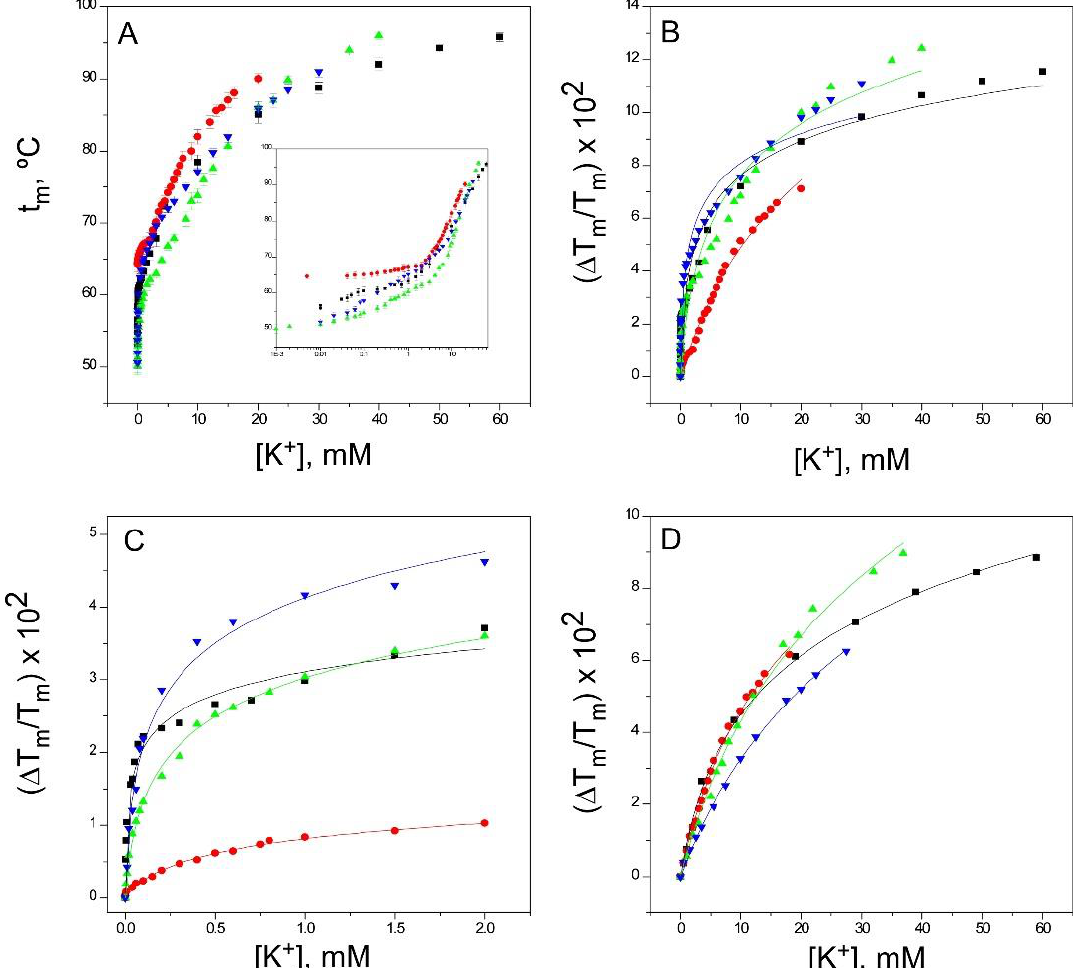
Figure 5. Binding of K + to KcsA. Panel A shows K + titrations covering the widest possible range of concentrations (i.e., those increasing the tm to near the thermostat limit of our circulating water bath) conducted on KcsA samples containing 1.5 mM Na + as the starting point. The results are the average (n = 3) tm (in Celsius) ± SD. The symbols and colors are the same as in Figure 2. Inset to panel A are semi-log plots of the binding processes to illustrate in a simple manner the presence of two different sets of K + binding sites. Indeed, fitting the data from panel A to Equation 1 fails when taking into account the whole titration curve (i.e., assuming a single set of binding sites) (Panel B ), but it suffices when the low (Panel C ) and the high (Panel D ) K + concentration ranges are analyzed separately, suggesting that at least two different sets of K + binding sites are present in the KcsA samples. The analysis of the binding data to more than one set of binding sites and the determination of the apparent dissociation constants for the individual binding events, as in Figures 5–7, have been described in detail in the Supplementary Information to Reference 33. The apparent K D values estimated for the above binding events are given in Table 1.